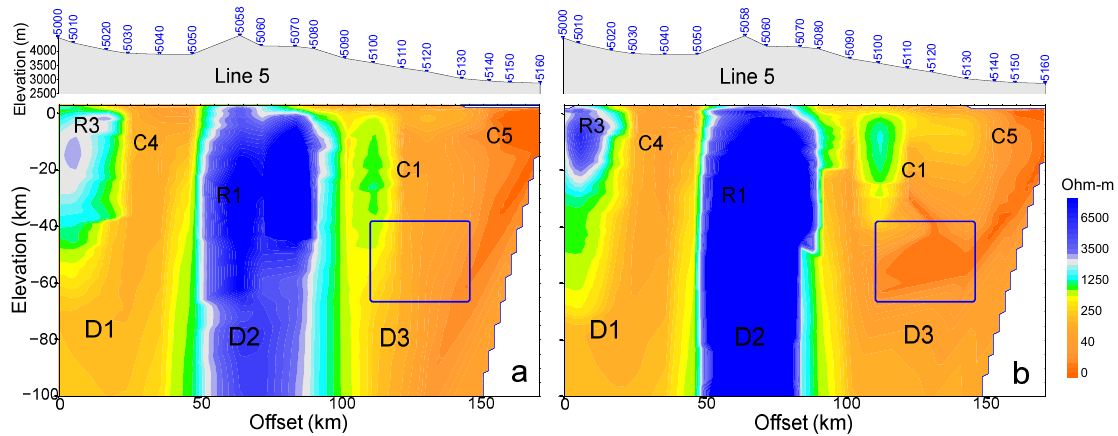
Figure 5. Resistivity conversion results of magnetotelluric (MT) sections Line 5 with a rotation of 62 degrees. ( a ) is the result of Rxy; ( b ) is those of Ryx.